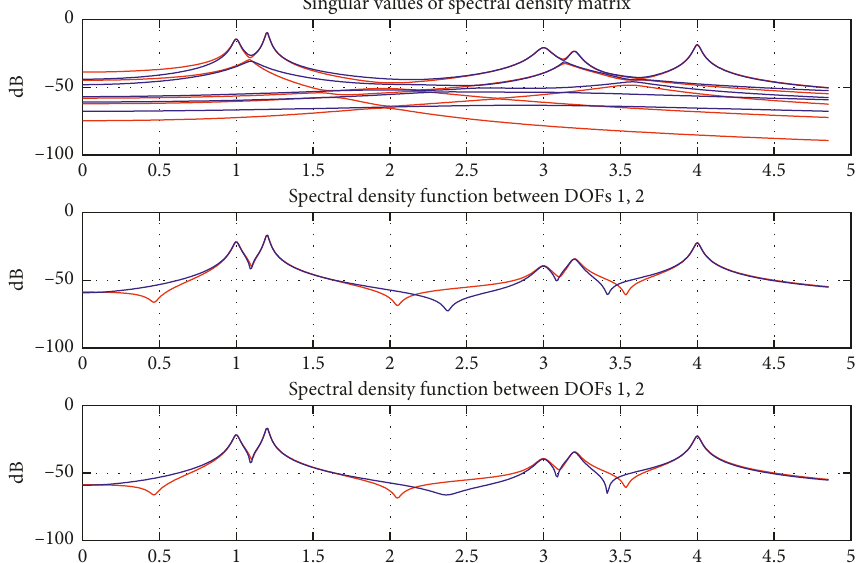
( f ) � G ( 1 , 2 )( f ) , between the y 12